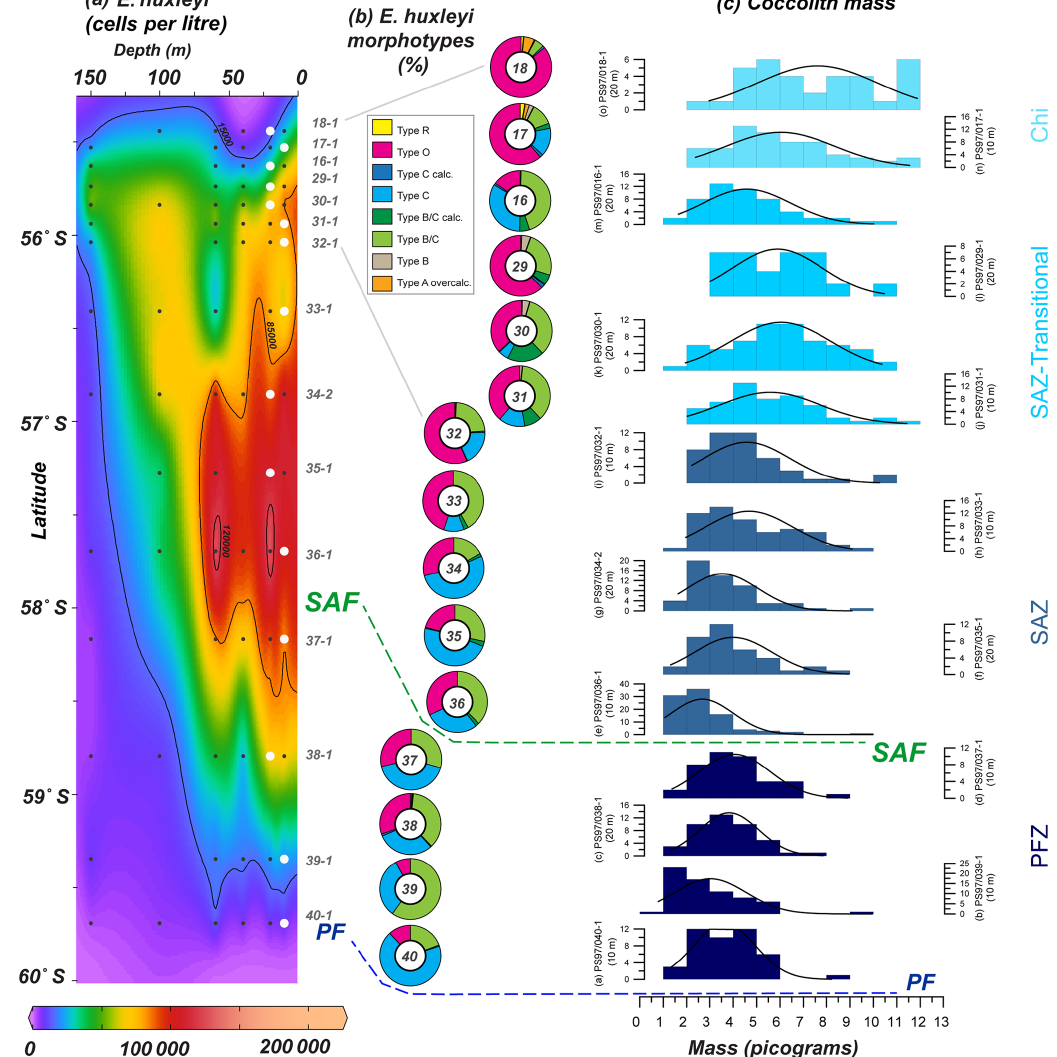
Figure 11. (a) Location of the PS97 CTD stations between 55.4 and 60 ◦ S, showing the number of cells per litre of Emiliania huxleyi from 0 to 150m. (b) Relative abundance of E. huxleyi morphotypes (including the different degree of calcification observed in SEM) in a latitudinal transect (10–20m; indicated with white dots in a ); (c) coccolith mass histograms at those specific locations. Bin size in (c) is 1pg, and normal distribution fitting line is shown. The station number, different zones (Chi – Chilean coastal zone; SAZ-Transitional – from Chi to open ocean; SAZ – Subantarctic Zone; PFZ – Polar Front Zone) and the main oceanographic fronts (Subantarctic Front – SAF – and Polar Front – PF), according to Orsi et al. (1995), are